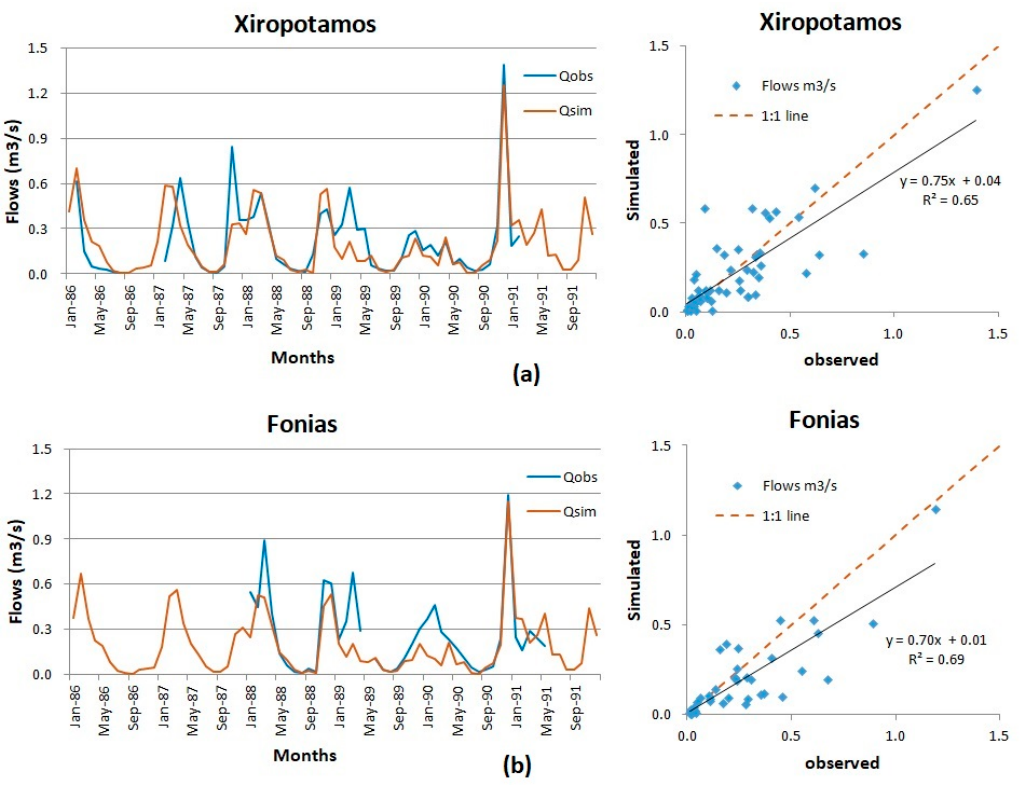
Figure 3. Stream flow evaluation in Samothraki: ( a ) monthly simulated vs. observed hydrograph at Xiropotamos stream (see Figure 2a) and correlation of flows on a two-axes scattergram, ( b ) monthly simulated vs. observed hydrograph at Fonias stream (see Figure 2a) and correlation of flows on a two-axes scattergram.